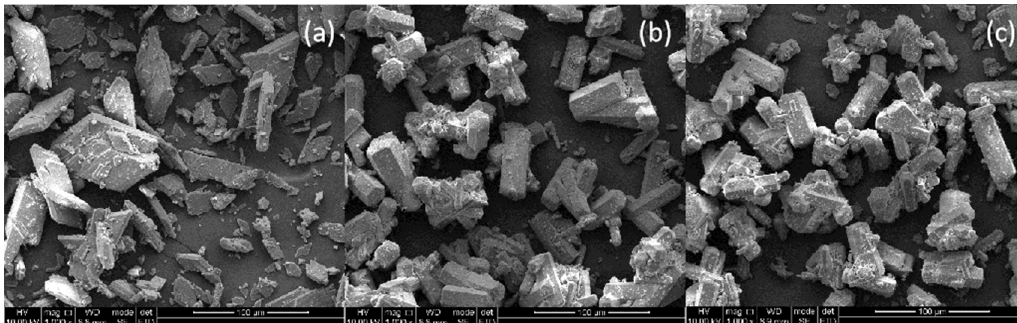
Figure 6 . SEM images of the solids withdrawn at 0 h ( a ), 1.5 h ( b ), 3.0 h ( c ) during the DH to α -HH transformation in a 2.47 M NaCl solution at 98.0 °C.